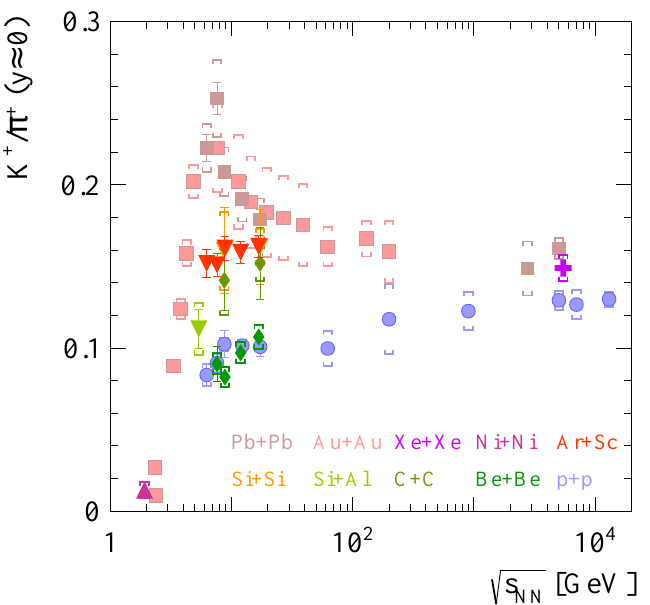
Figure 2. Status of experimental results on energy dependence of the K + / π + ratio at mid- rapidity in high-energy nuclear collisions. In addition to the previously shown results on central heavy-ion collisions [16–26] and inelastic p+p [19,27–31] interactions, results on central Be+Be [46], C+C [47,48], Si+Al [49], Si+Si [47,48], Ar+Sc (preliminary) [50,51], Ni+Ni [52,53] and Xe+Xe [54] colli- sions are shown. Points presenting Pb+Pb/Au+Au and p+p are plotted in pale colours to emphasize intermediate-mass nuclei results.